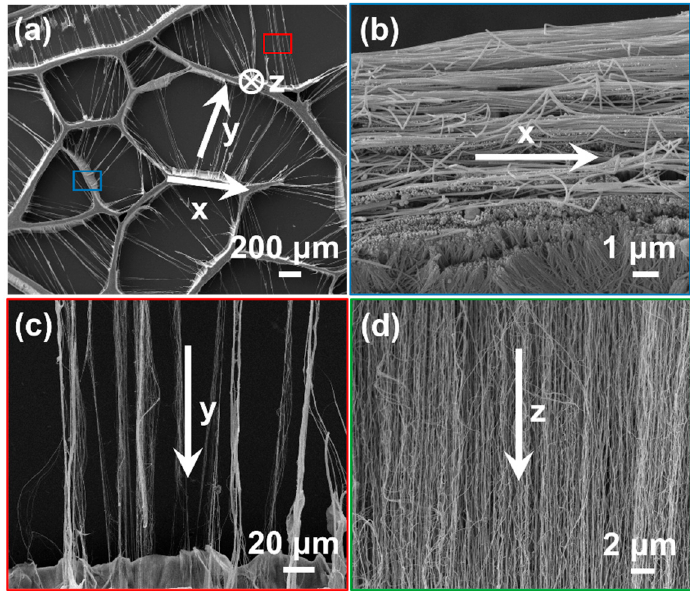
Figure 2. SEM images of the as-prepared NWs array with multidimensional orientation. ( a ) The top-view SEM image of the multidimensional aligned NWs array, exhibiting a typical polygon-shape structure. The SEM image reveal that the horizontally oriented NWs, CNT yarns in x, y direction, vertically aligned ACNTs in z direction, respectively. ( b ) The SEM images of top-layer oriented AgNWs. ( c ) The SEM image of CNT yarns in y direction. ( d ) The SEM images of under-layer bundled ACNTs in z directions.